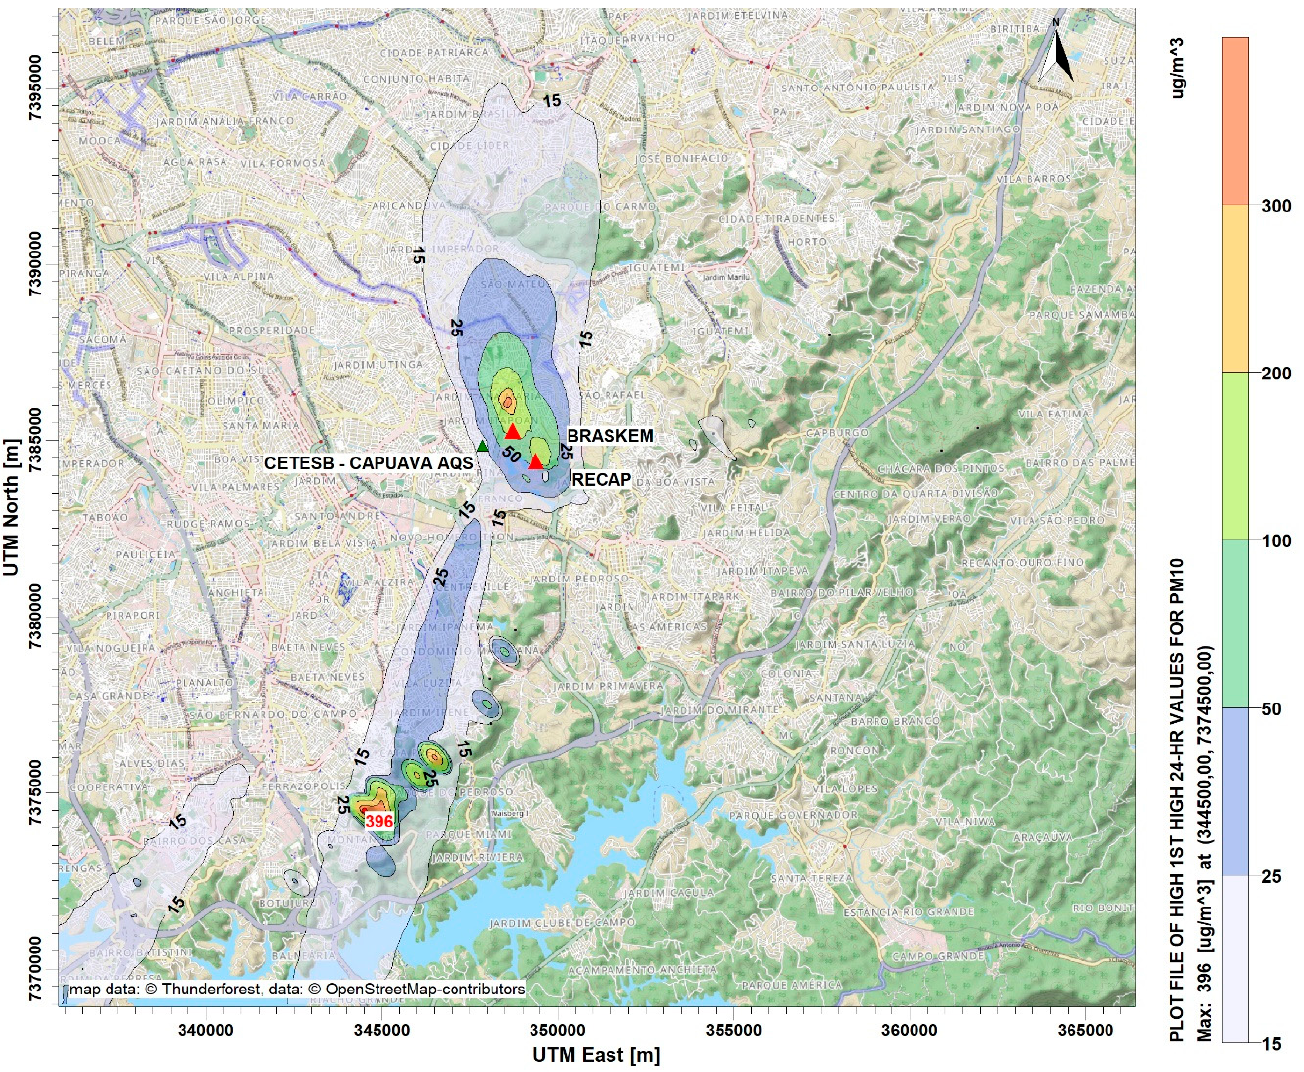
Figure 8. The maximum concentration of 24 h average (µg m − 3 ) of PM in the affected area during the CPC maintenance period.